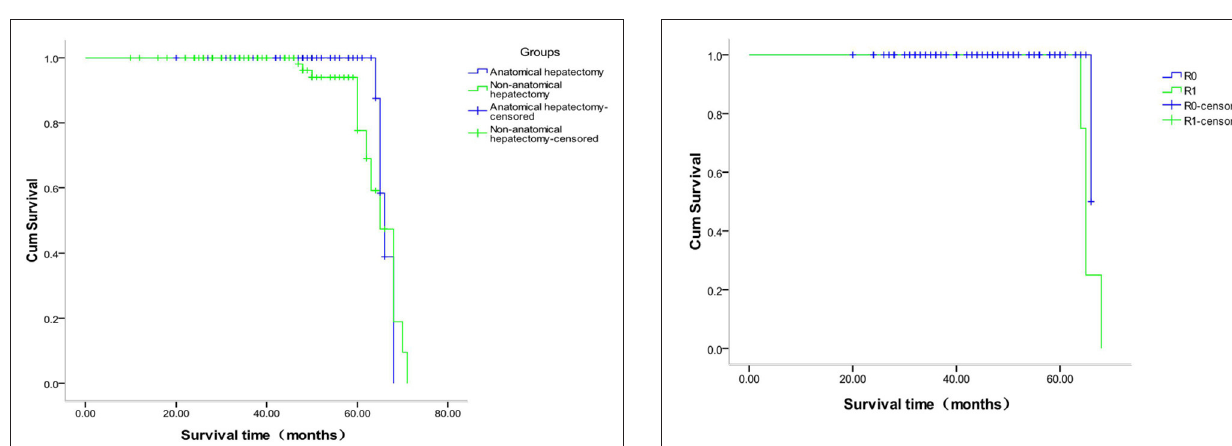
FIGURE 7 | Survival curve of patients with different surgical margins after anatomical hepatectomy.